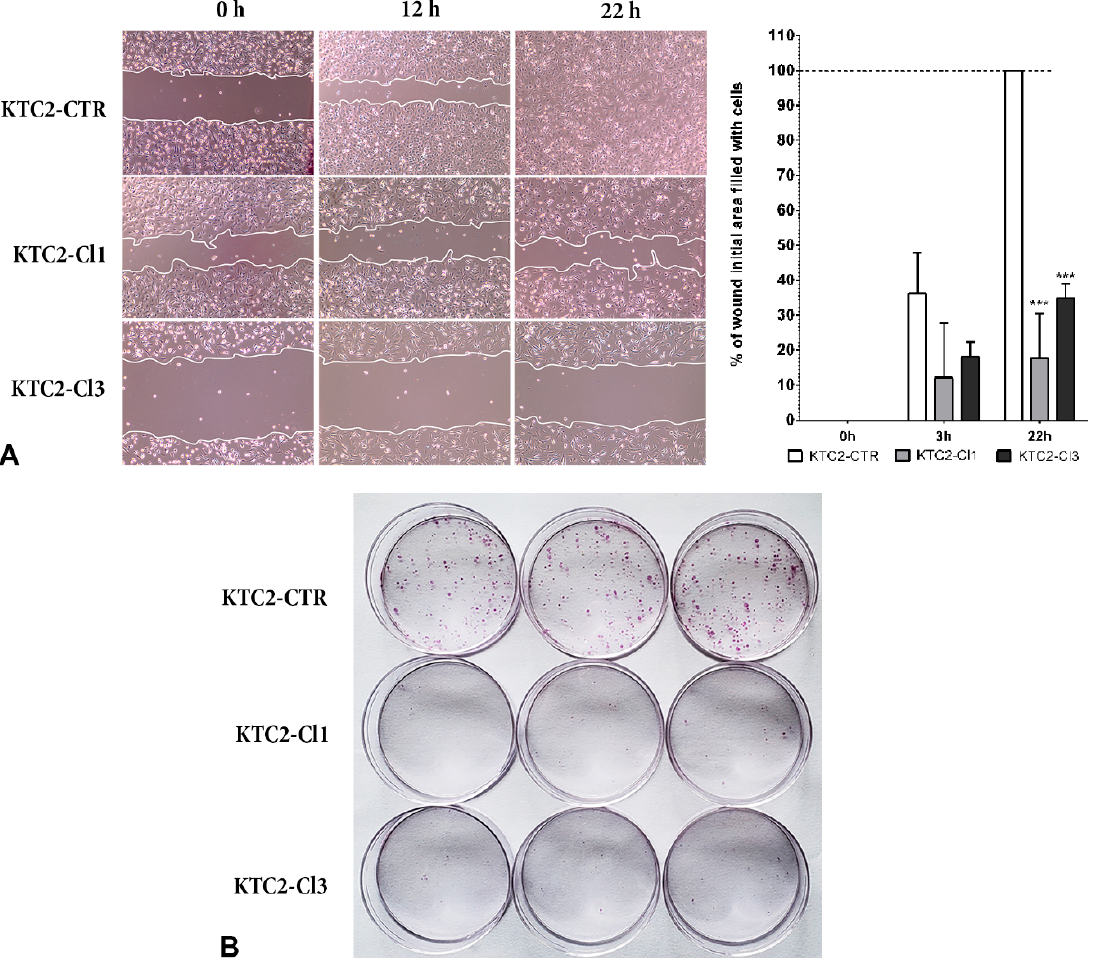
Figure 5. ( A ) Wound healing assay to evaluate cell migration in mitomycin treated KTC2-CTR cells compared to KTC2-Cl1 and Cl3 cells. Representative image of the gap closure soon after wound (0 h) and after 3 h and 22 h. The graph shows quantification of the area of the wound filled with cells compared to 0 h area (0% filled) using ImageJ software. *** p < 0.01 vs. KTC2-CTR ( B ) Colony formation assay comparing KTC2-CTR, KTC2-Cl1 and KTC2-Cl3 cells’ ability to form clones after low density seeding for 8 days. Representative results of two independent experiments performed in triplicate.